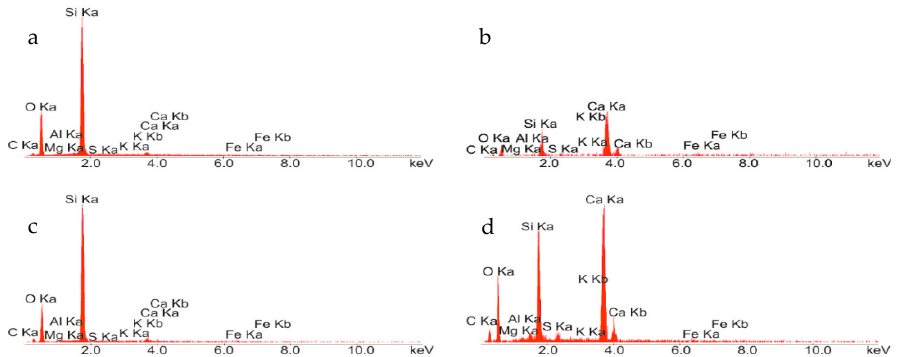
Figure 2. X-ray microanalysis: ( a ) in point 1 of Figure 1a: a quartz particle, ( b ) in point 2 of Figure 1a: C–S–H phase, ( c ) in point 2 of Figure 1b: quartz particle, ( d ) in point 1 of Figure 1b: C–S–H phase.